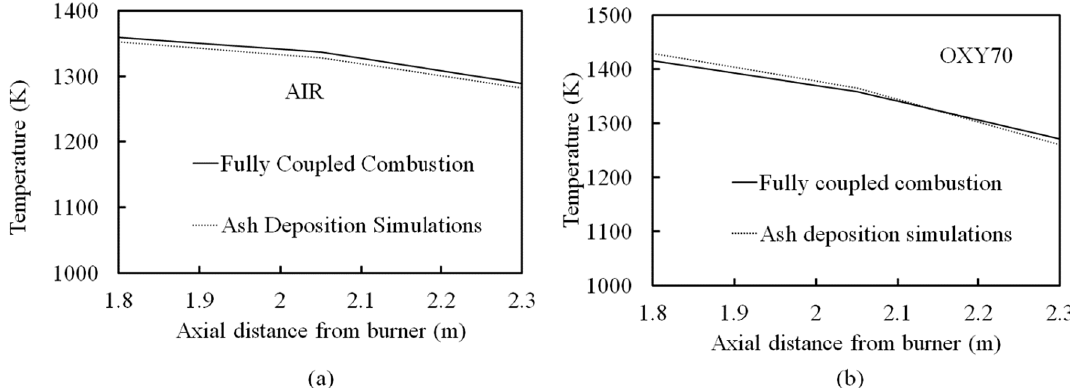
Fig. 5 Comparison of centerline temperature predictions along the axial length of the combustor between the fully coupled combustion calcula- tion and the ash deposition simulations (probe location is at an axial distance of 2.3 m from the burner) a AIR b